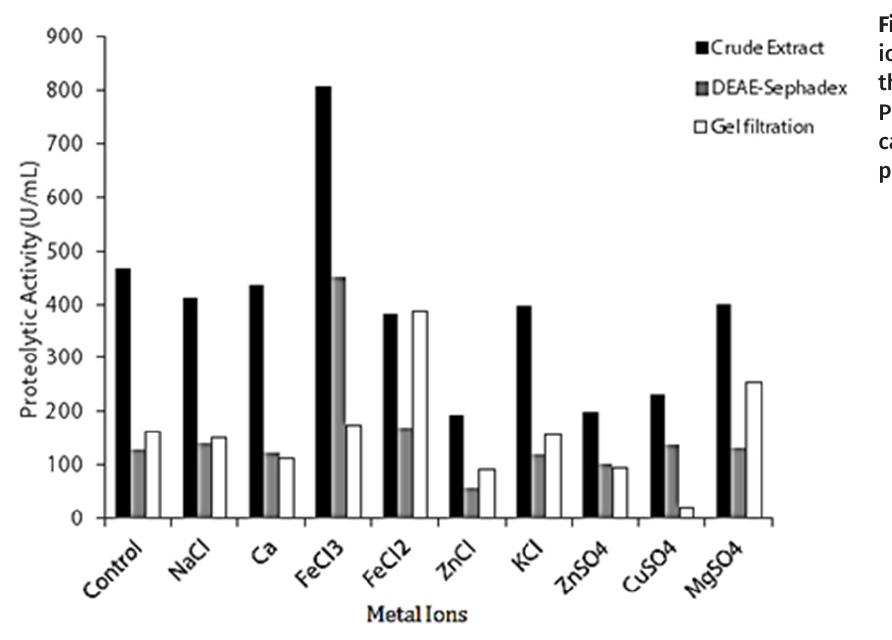
Figure 4. Effect of metal ions and inhibitors on the protease activity. Protease assays were carried out using purified protease